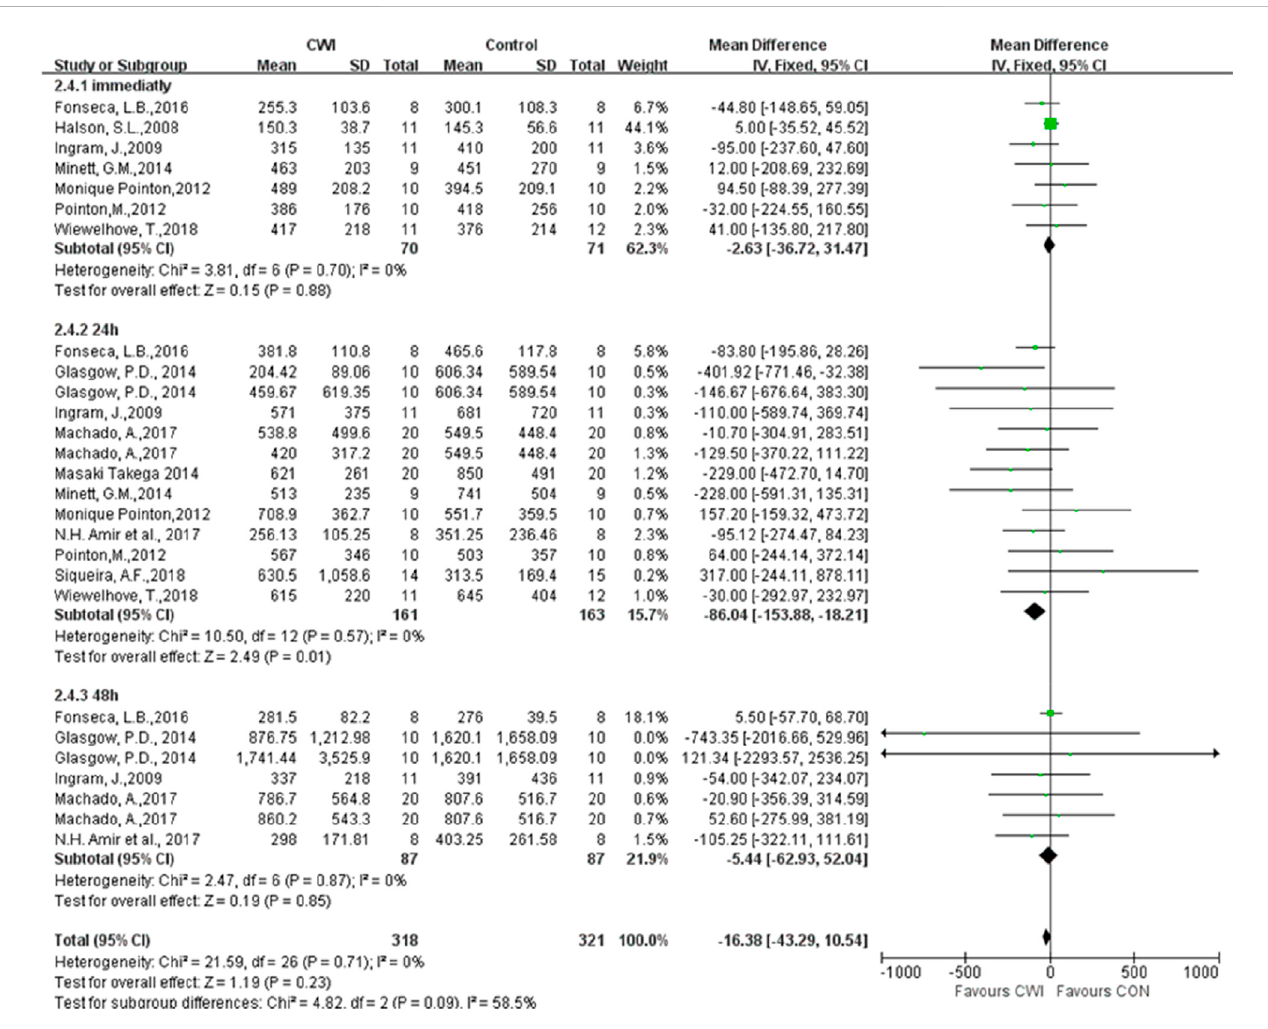
FIGURE 7 Forest plot of the comparison of CWI versus CON for measurement of CK. CWI = Cold water immersion, CON = Control, CK = creatine kinase.